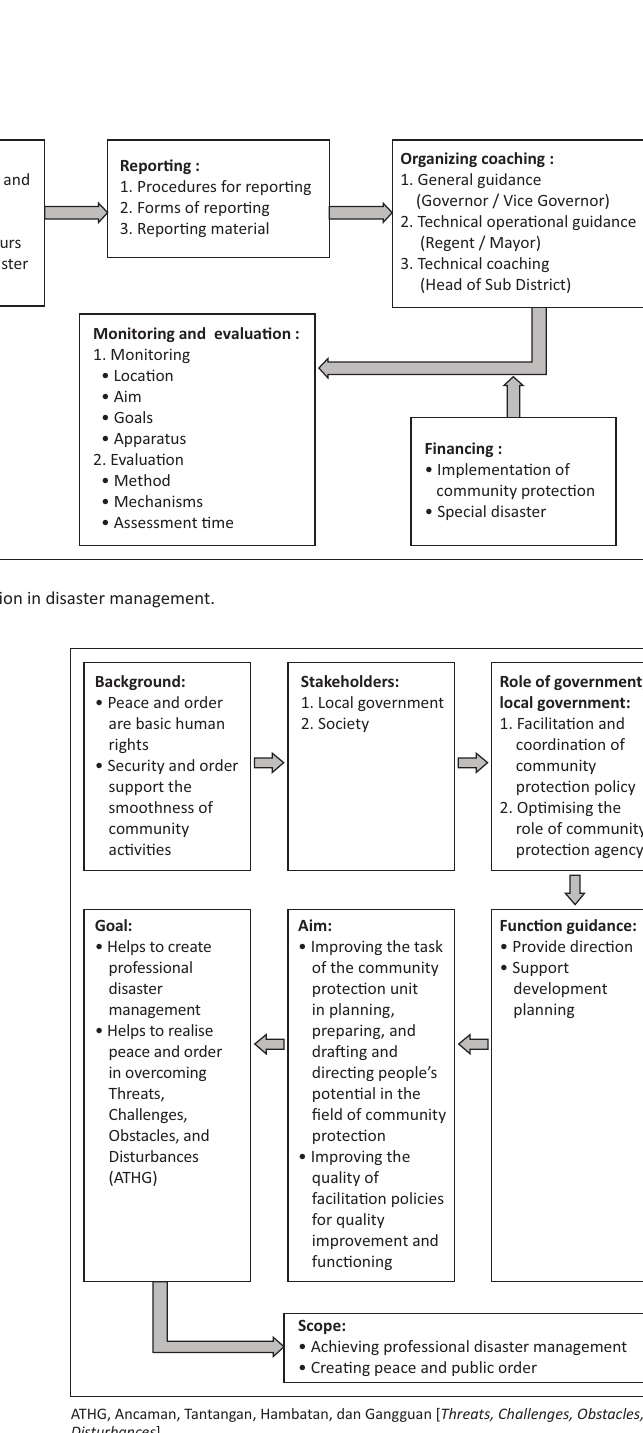
FIGURE 4 : Position and function guidelines for the development of community